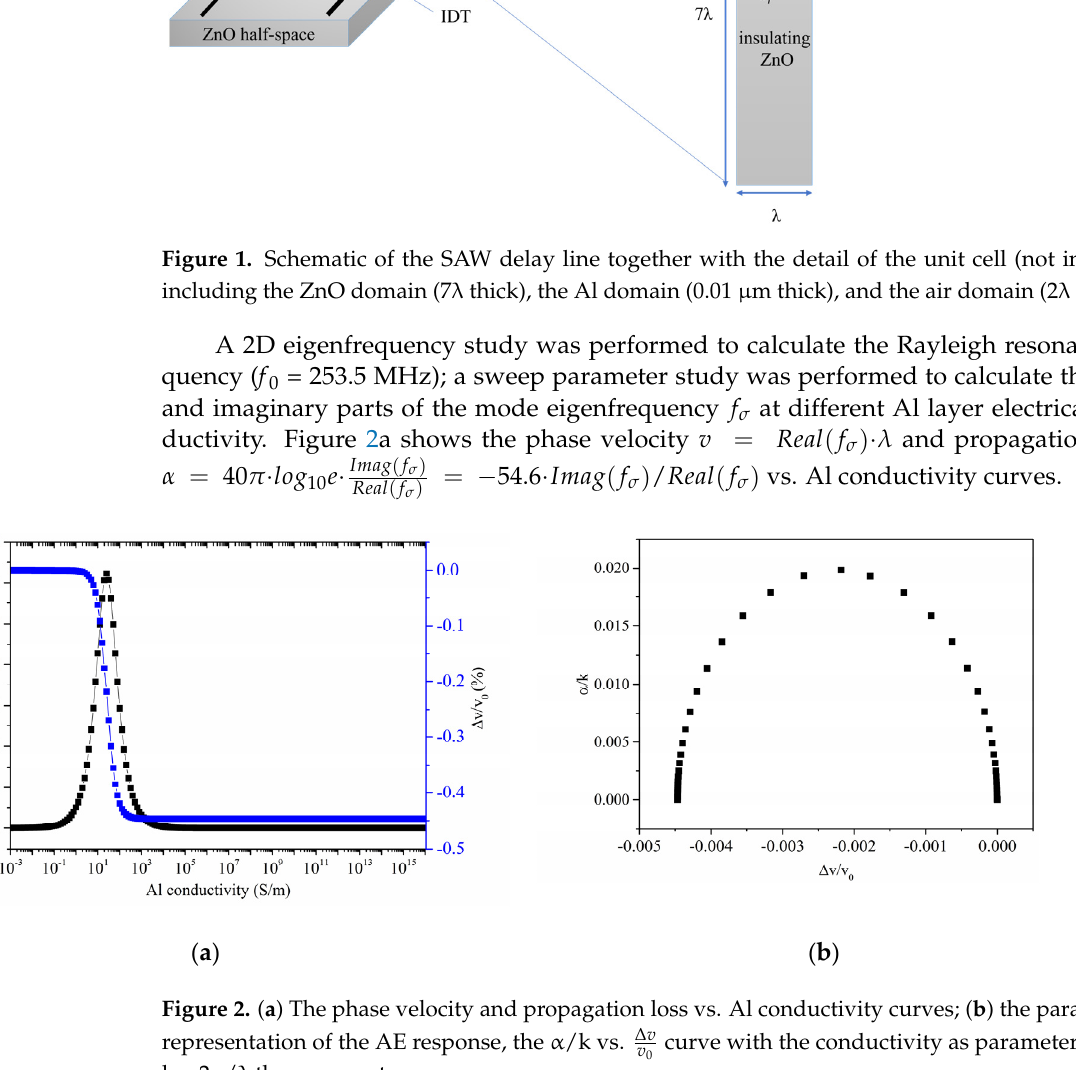
(cid:3415) curve with the conductivity as parameter, ∆ v curve with the conductivity as parameter, being (cid:2868) v 0